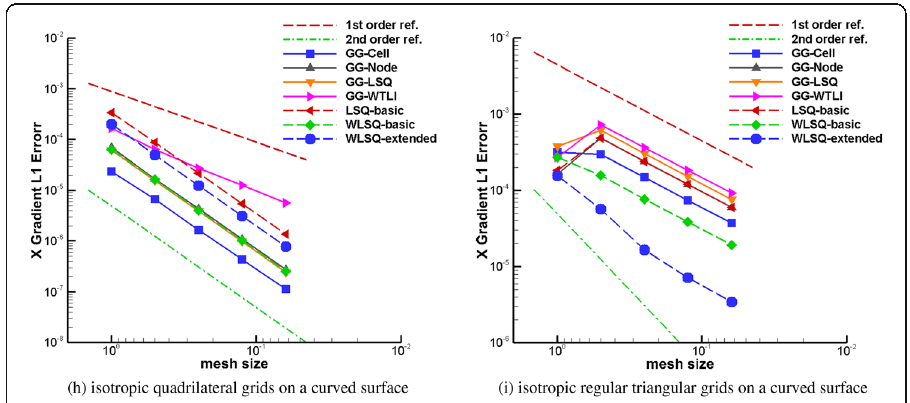
Fig. 10 Convergence of x-direction gradient of different grids and different reconstruction methods. h Isotropic quadrilateral grids on a curved surface. i Isotropic regular triangular grids on a curved